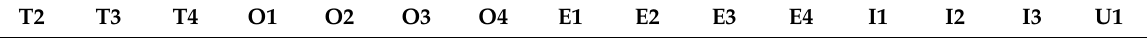
Table 4. Discriminant validity